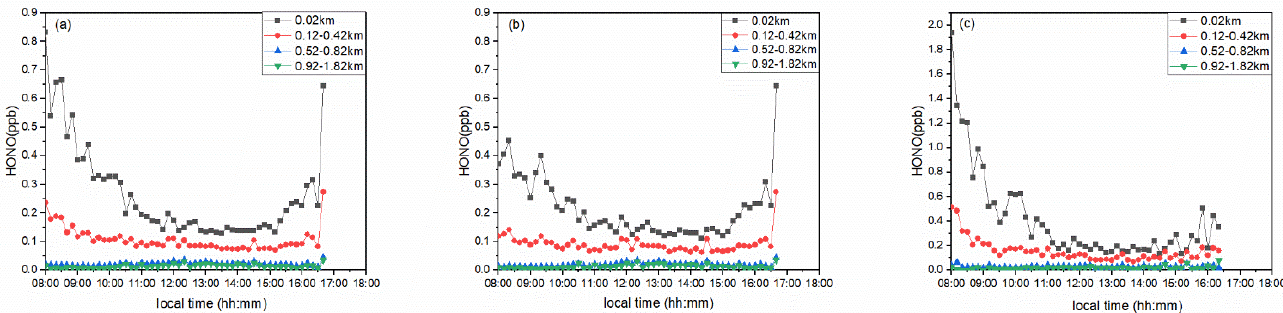
Figure 9. Diurnal variations of HONO at different altitudes. ( a ) is average of all the valid days; ( b ) is clear days; ( c ) is haze days. Different colored lines represent different altitudes: 0.02 km black; 0.12–0.42 km red; 0.52–0.82 km blue; 0.92–1.82 km green.